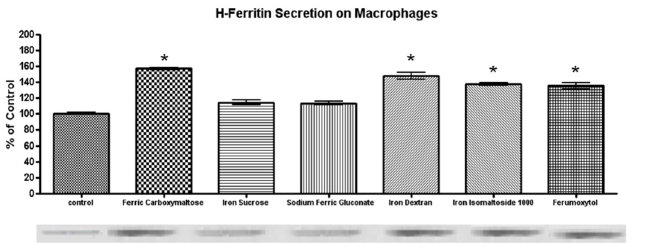
Fig 11. H-ferritin secretion by primary peritoneal macrophages after iron compound treatment for 24 hours: Rat peritoneal macrophages were obtained by peritoneal lavage. The cells were exposed to 0.1 mg/ ml of elemental iron for each of the iron formulations for 24 hours. The media was then replaced for 24 hours and then an aliquot taken for H-ferritin analysis. A representative immunoblot (21 kDa band) is shown and the data for 3 experiments are presented in the graphs. The data show that exposure to ferric carboxymaltose, iron dextran, iron isomaltoside and ferumoxytol is associated with an increase in ferritin release by the macrophages compared to control (untreated) but there is no increase following iron sucrose or sodium ferric gluconate exposure (p < 0.05). The expression levels were normalized to β